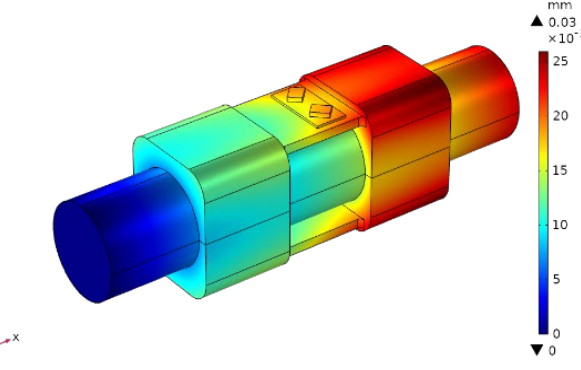
Figure 11. Cloud chart of total shape variable. As shown in Figure 12, the strain analysis of SAWR is carried out separately.